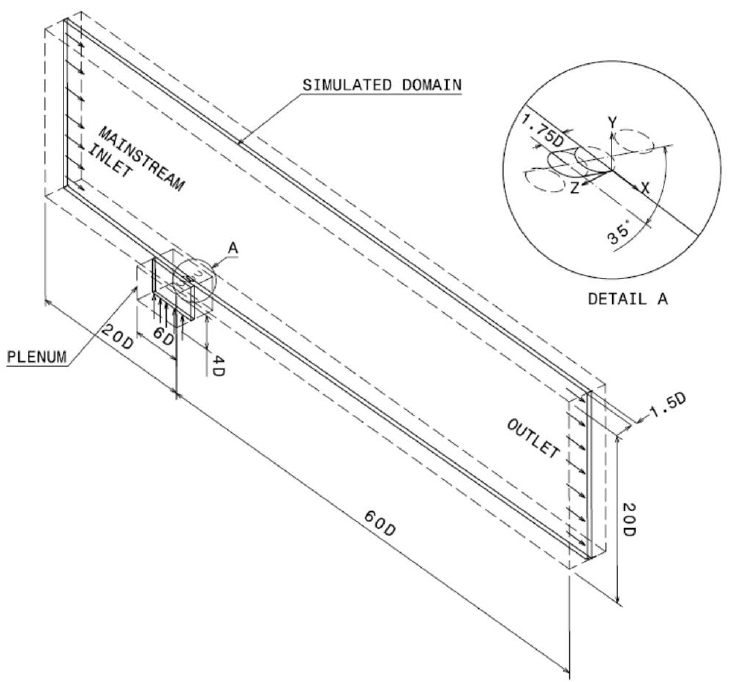
Figure 1. Geometry and boundary conditions of the baseline geometry.